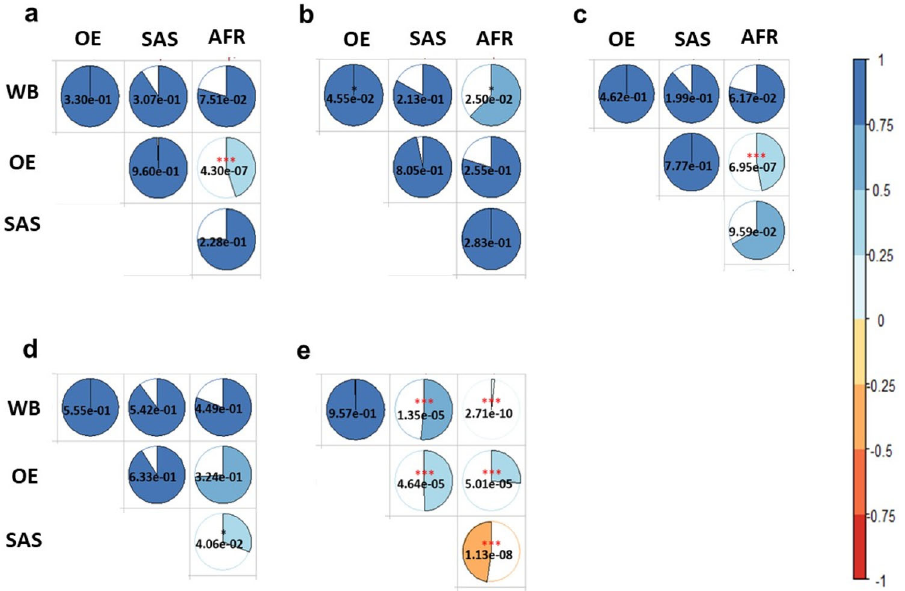
Fig. 6 | Estimated cross-ancestry genetic correlations for a broader range of phenotypes. The phenotypes are a Basal metabolic rate, b Body fat percentage, c Whole body fat-free mass, d Pulse rate and e Education. The colour and size of each pie chart indicates the magnitude of estimated cross-ancestry genetic corre- lations. WB,OE, SAS,and AFR indicate White British, Other European, South Asian,